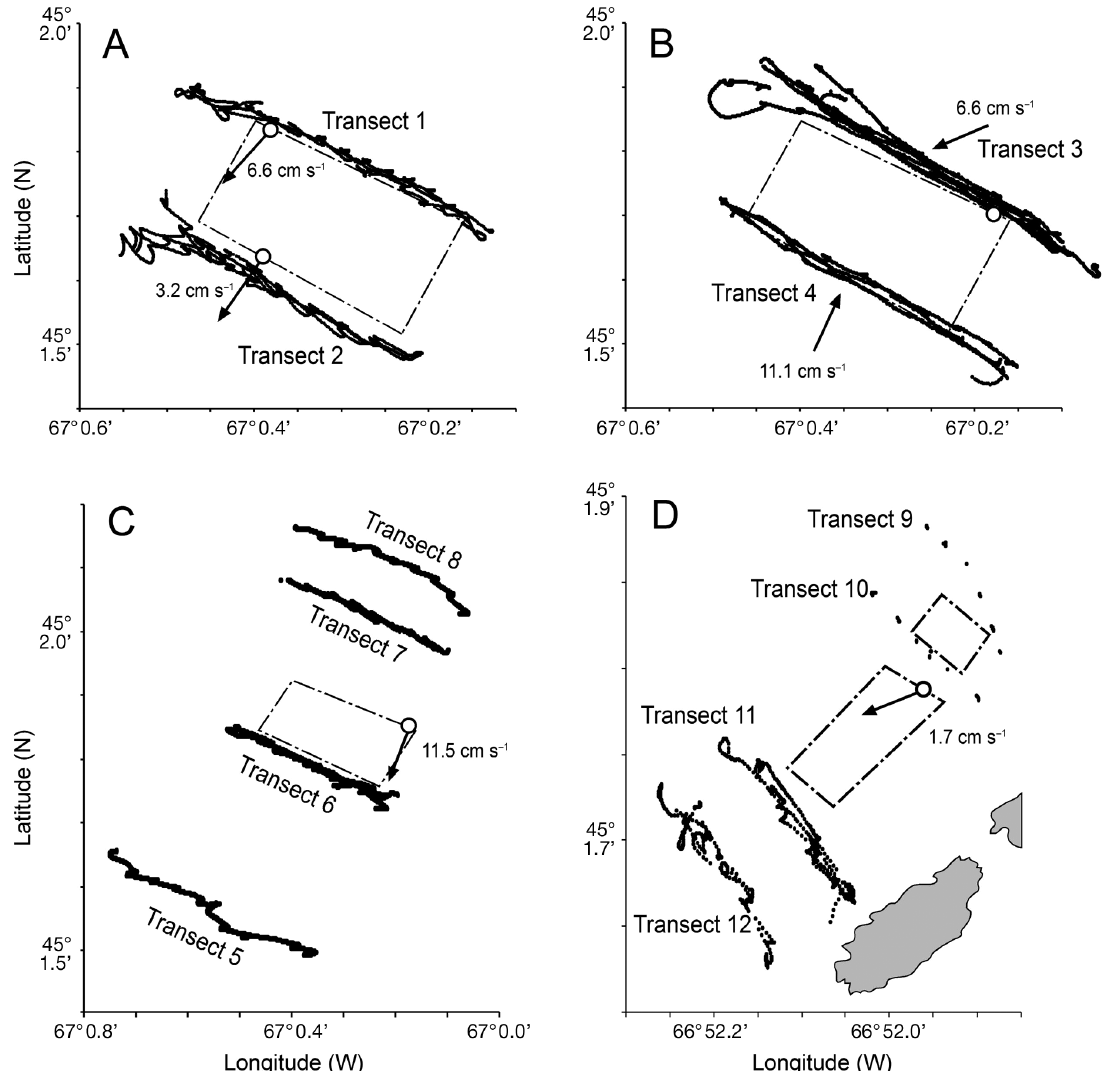
Fig. 3. Sampling locations along the WASP vertical profiling transects at (A) the Navy Island salmon farm on 16 November 2010, (B) 30 November 2010, and (C) 1 December 2010, and at (D) the Charlie Cove farm on 7 July 2011. Transects 3 and 4 were sampled on ebb and flood tide, respectively. Dot/dash lines depict farm boundaries. The average current speed is given for each sampling period and the prevailing direction is indicated by arrows. Current meter locations are shown as open